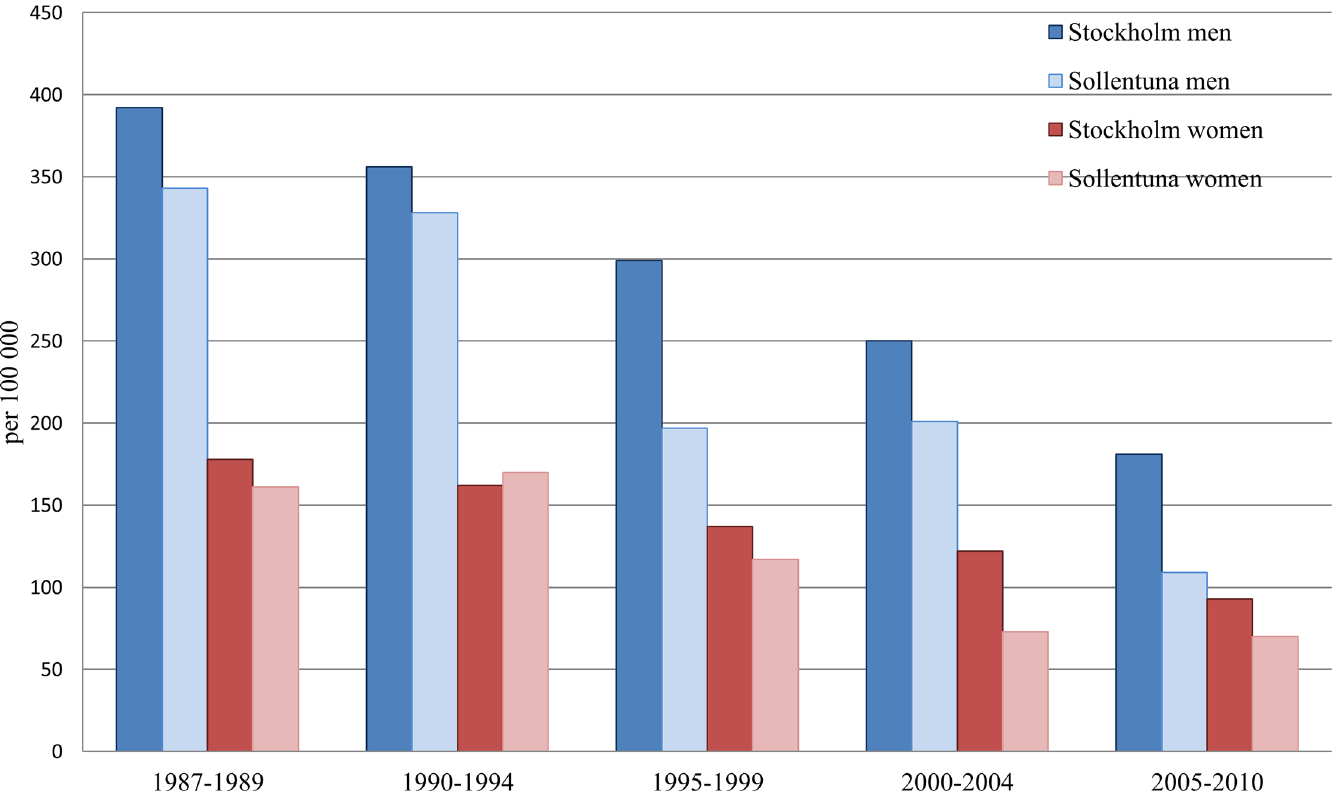
Fig 2. Age standardized AMI mortality in men and women per 100 000 inhabitants in Stockholm and Sollentuna in five year groups between 1987 to 2010.